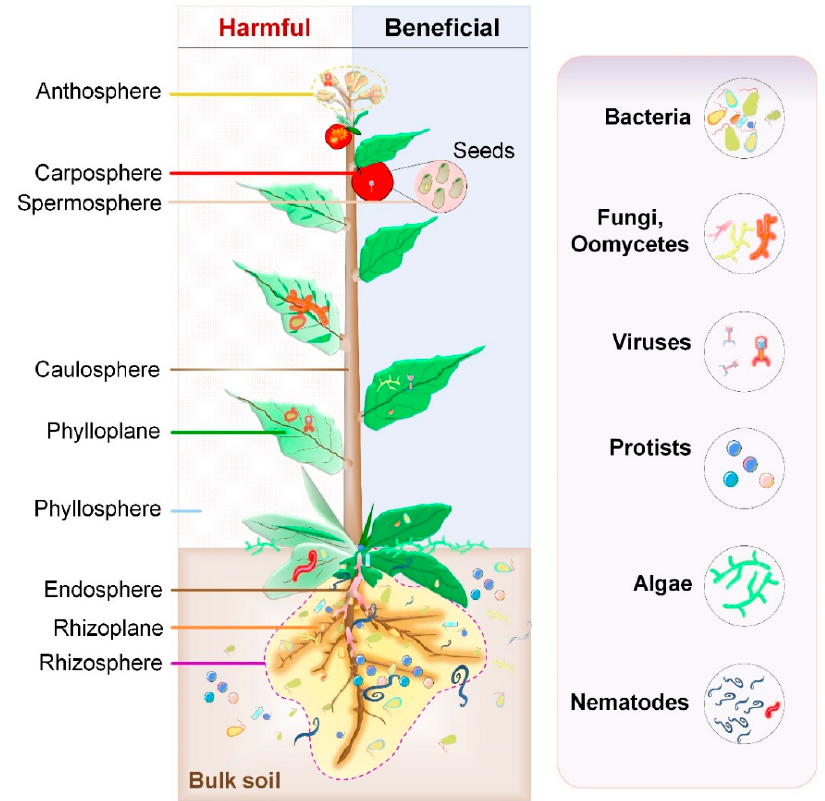
Figure 1. Microbiome in plant ecosystem. Schematic plant and plant-associated microbiota colonizing different niches on and inside the plant tissue. All the above-ground plant parts together, called the phyllosphere, are a continuously evolving habitat due to ultraviolet (UV) radiation and altering climatic conditions. It is primarily composed of leaves. Below-ground plant parts, mainly roots, are generally influenced by soil properties. Harmful interactions affect the plant growth through pathogenic activities of some microbiota members (left side). On the other hand, beneficial microbial interactions promote plant growth (right side).